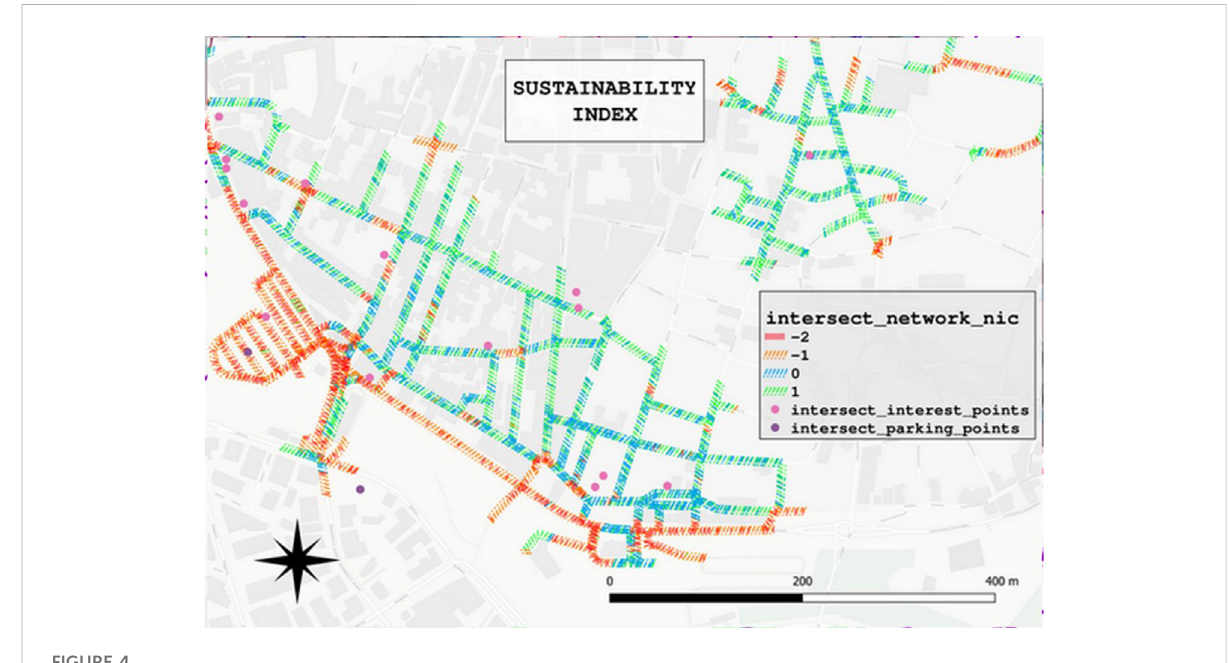
FIGURE 4 Intermodal walkability index fi nal